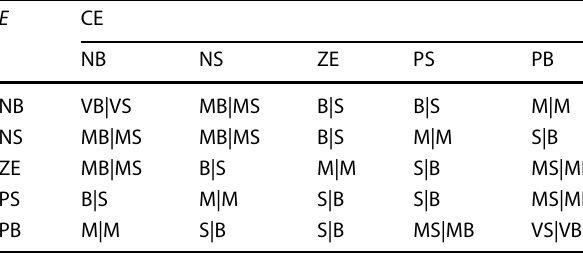
Table 1 Rule base of K